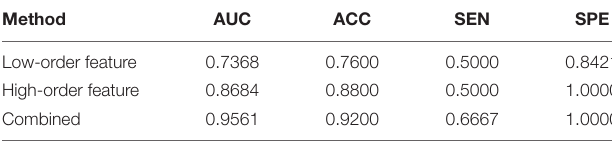
TABLE 2 | Comparison of recognition results on the independent test set.